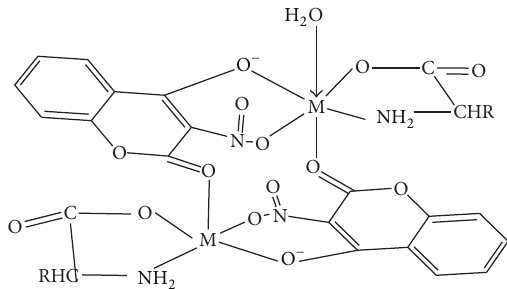
Figure 3: Proposed structure for compounds 3 and 5 . R=– H, compound 3, and –C 4 H 8 , compound 5 .